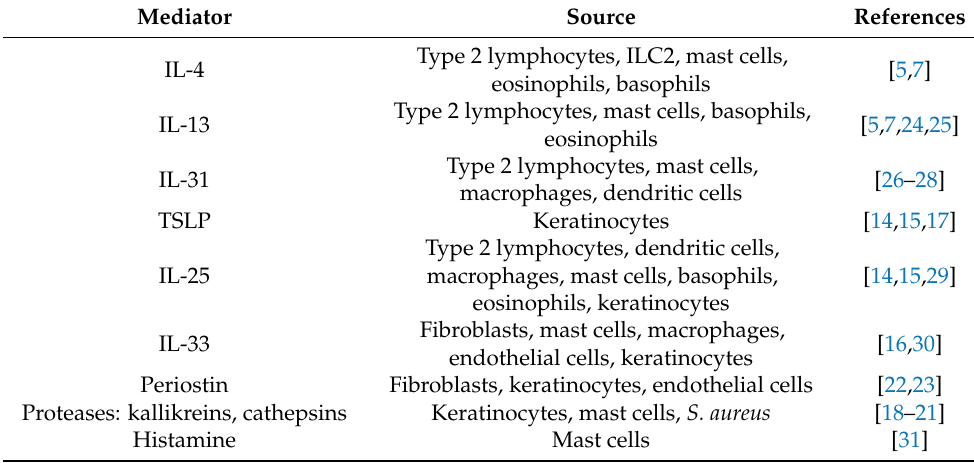
Table 1. Principal itch mediators and their principal cells of origin.